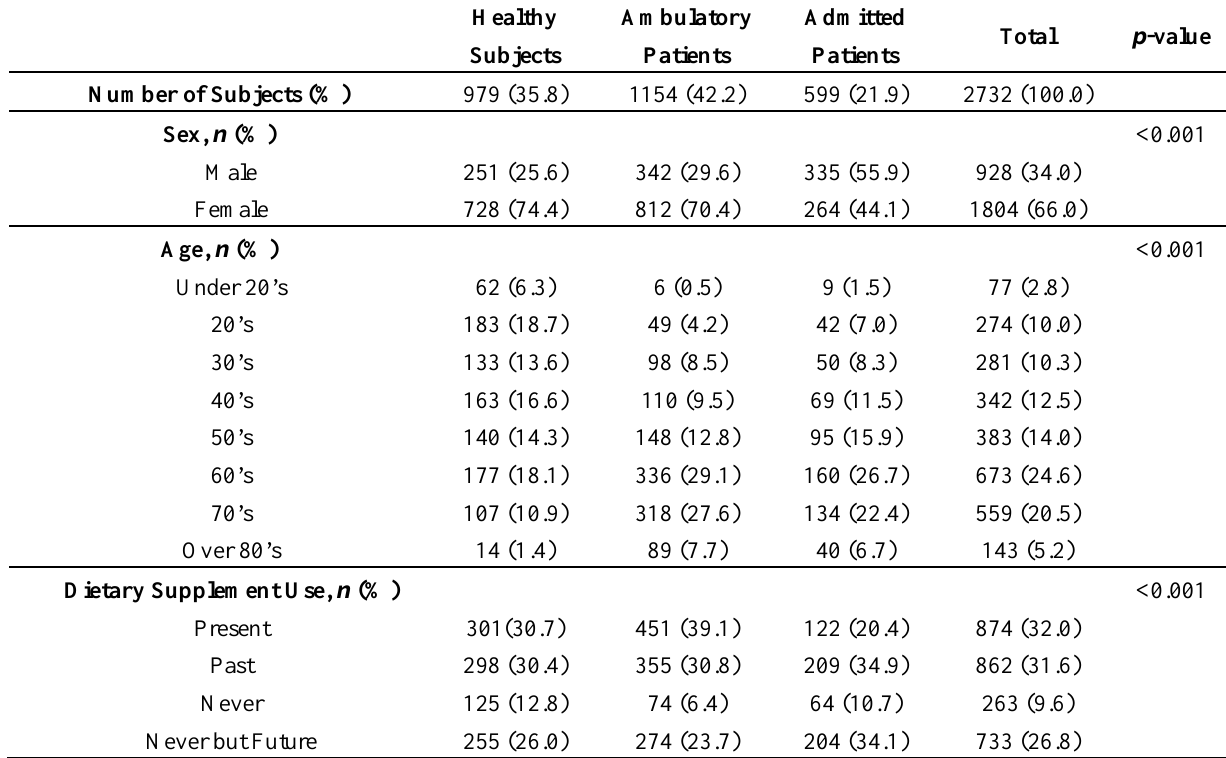
Table 1. Characteristics of each